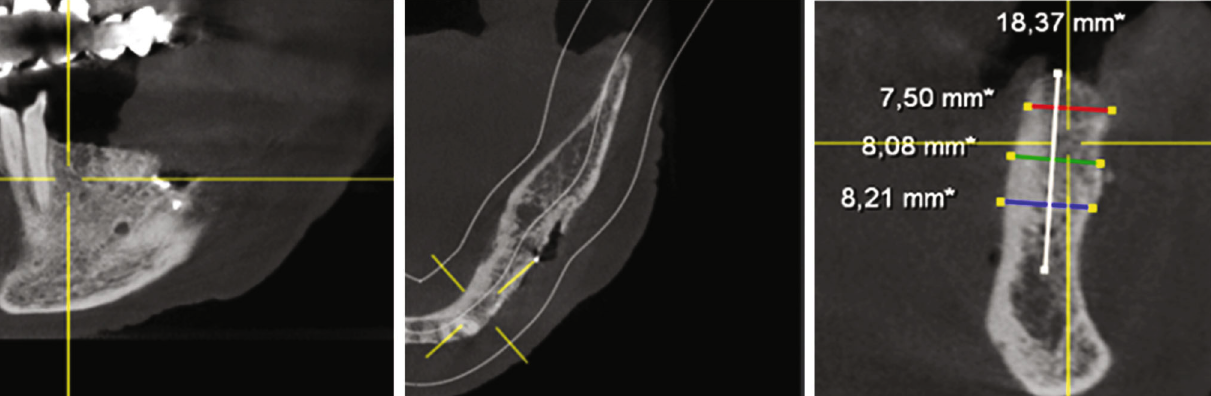
Figure 18: DVT — section; implant position region 34.